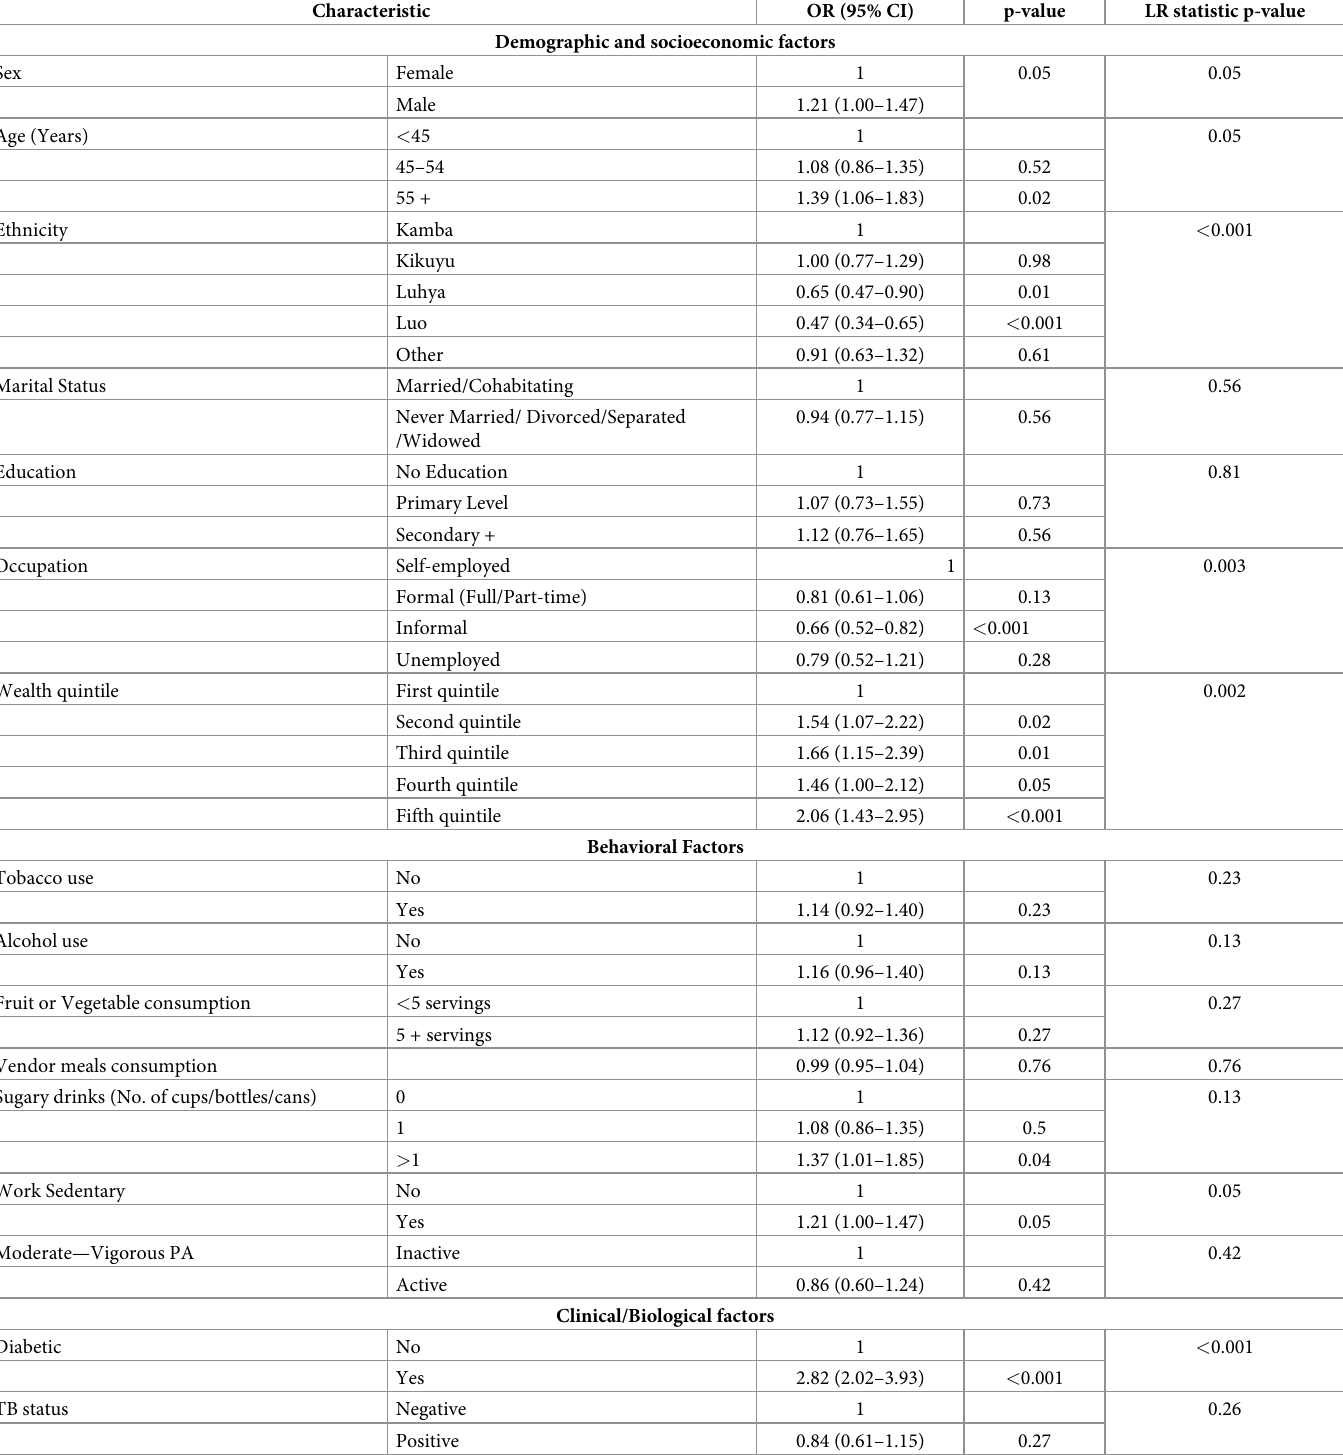
Table 3. Univariate ordered logistic regression models of factors associated with higher atherogenic